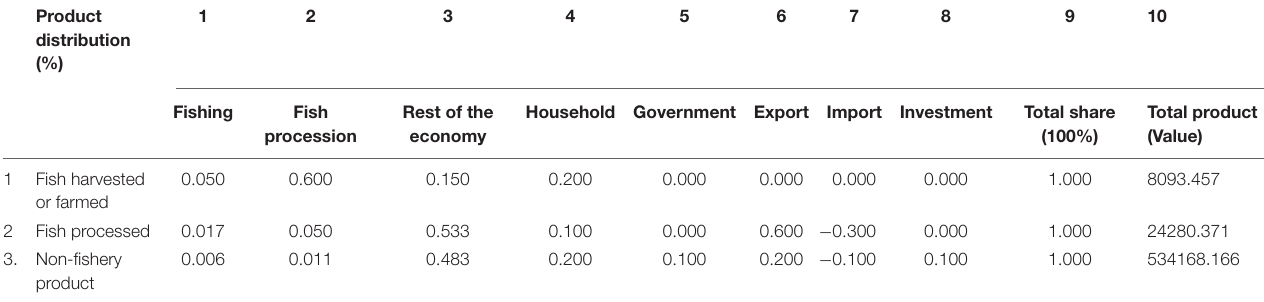
TABLE 2 | The input–output data of fishery sectors.